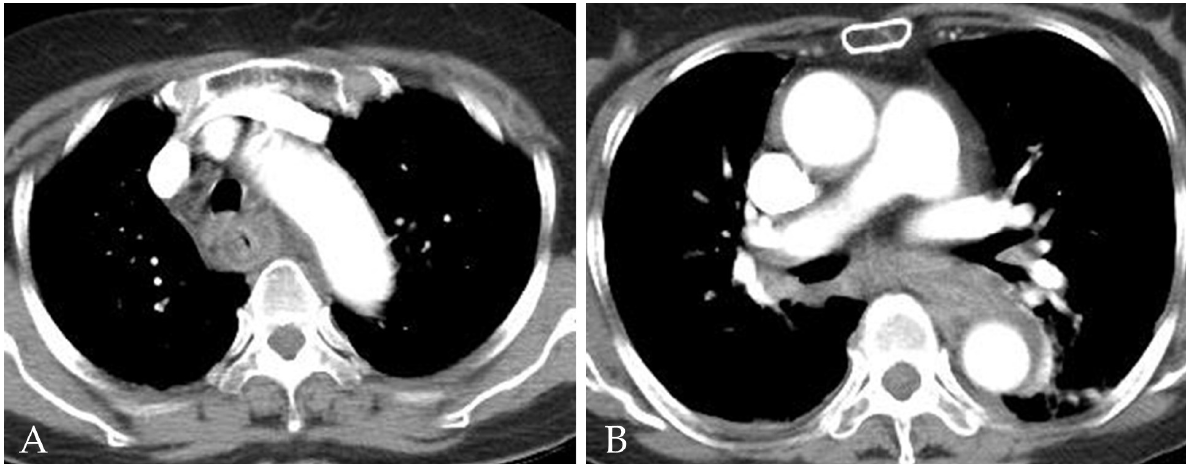
Figure 1. A 76-year-old woman with acute phlegmonous esophagitis. ( A , B ) Axial contrast-enhanced CT images show diffuse circumferential esophageal wall thickening with low-density submucosa along the entire esophagus, increased mediastinal fat strand, and peri-esophageal fluid collection.